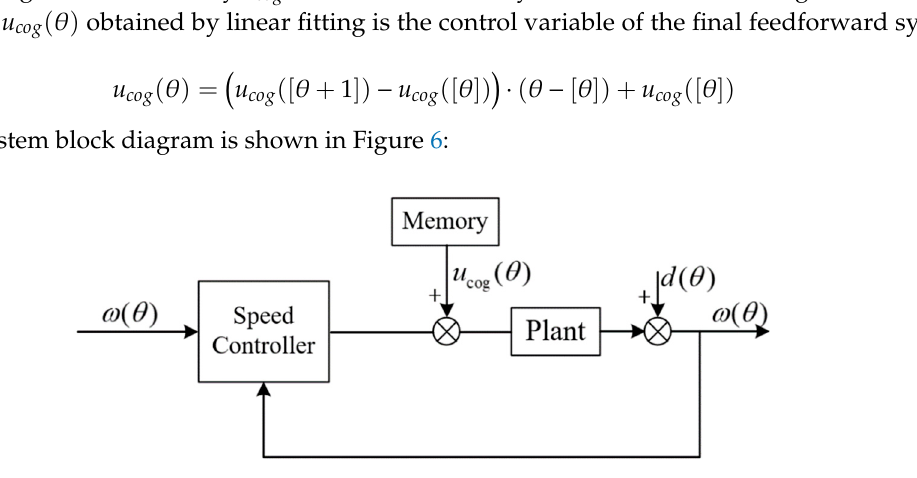
u with the mechanical angle θ . Figure 5. Variation of u cog with the mechanical angle cog